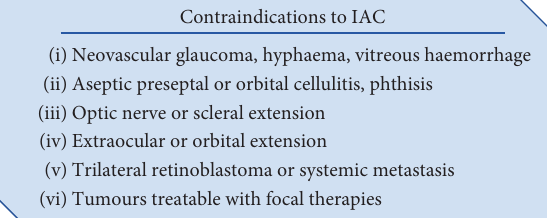
Figure 5: Contraindications to IAC [5].